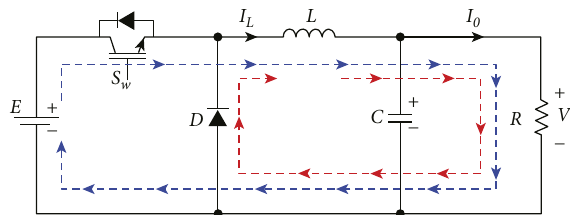
Figure 1: Te circuit model of the buck converter (blue line: the switch is on; red line: the switch is